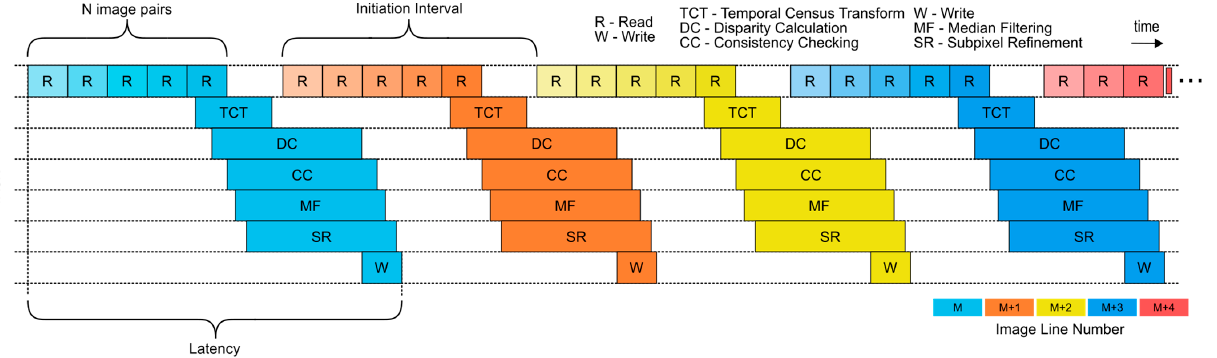
Figure 3. A high-level overview of task pipelining in the design. The task schedule presented in Figure 3 indicates several key points of the proposed design. The initiation interval is the time that must elapse between issuing two tasks of the same type. Because we are working with temporal data, several non-sequential read operations (non-sequential in terms of in-memory location) must be made to load the appropriate data from the external memory into the hardware accelerator. Every read operation has to be issued for a large, contiguous memory region (e.g., image line) in order to minimize the penalty of external memory access. After the data have been read from